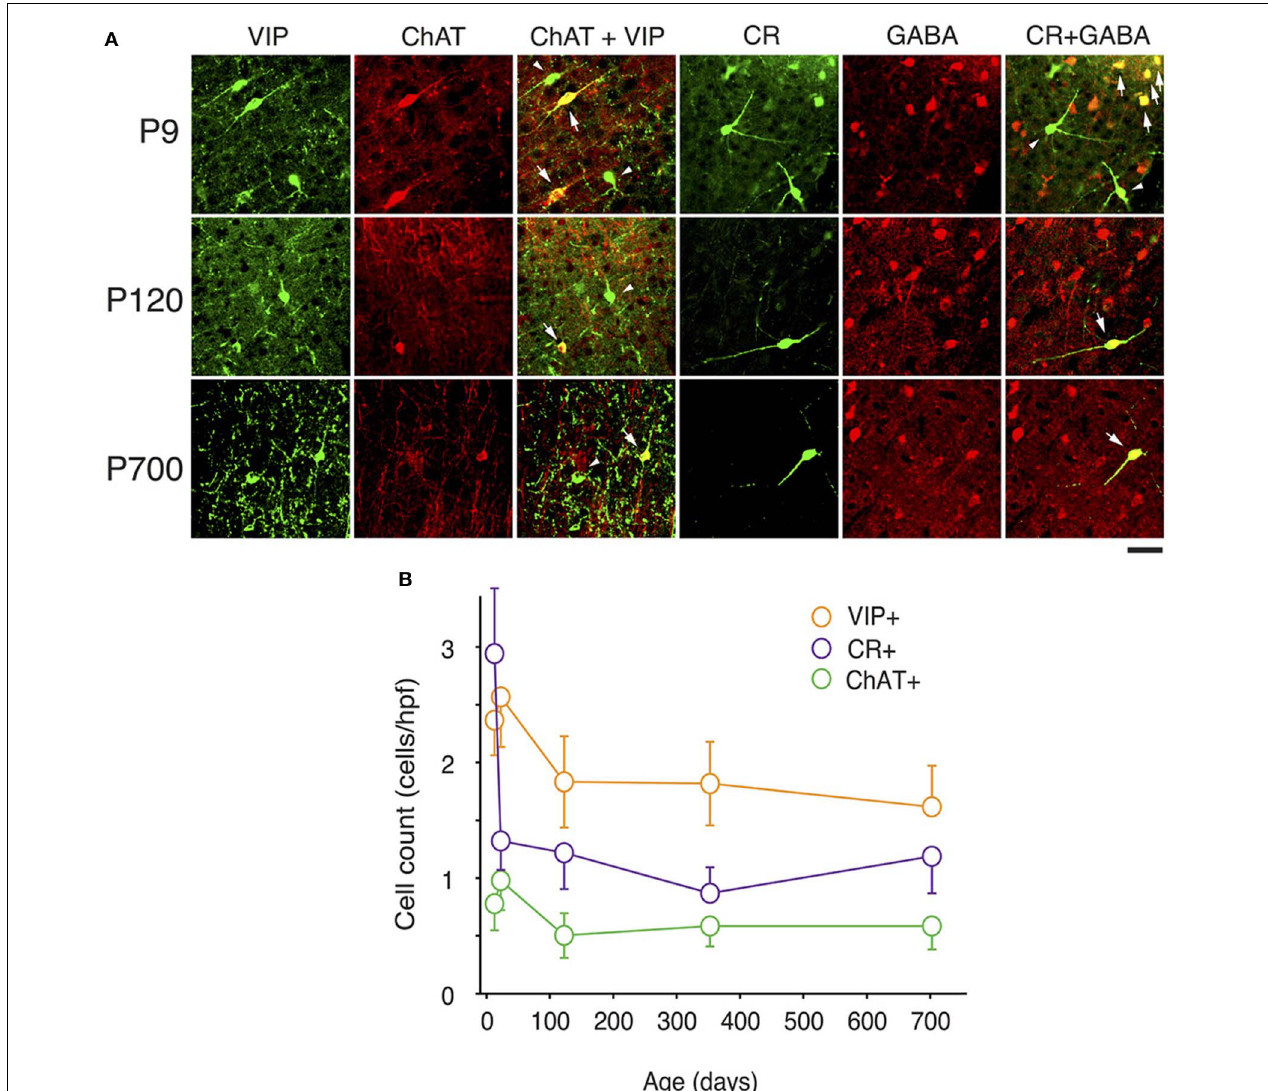
FIGURE 2 | Expression of CR, VIP, and ChAT markers in A1 GABAergic neurons across the lifespan. (A) Representative high power (40X) confocal photomicrographs of ChAT + , VIP + , and CR + immunolabeled cells for three age bins. Co-staining between VIP and ChAT was observed for 50% of neurons at all ages examined (arrows show cells with double labeling, triangles point to VIP + /ChAT − cells). Co-localization